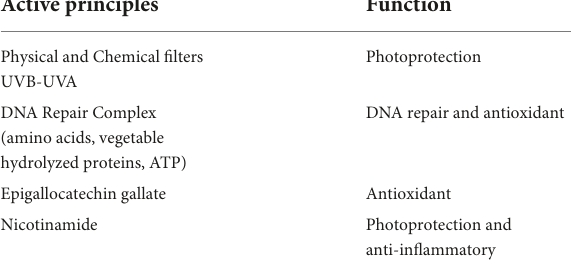
TABLE 2 R (cid:13) Rilastil AK Repair 100 +